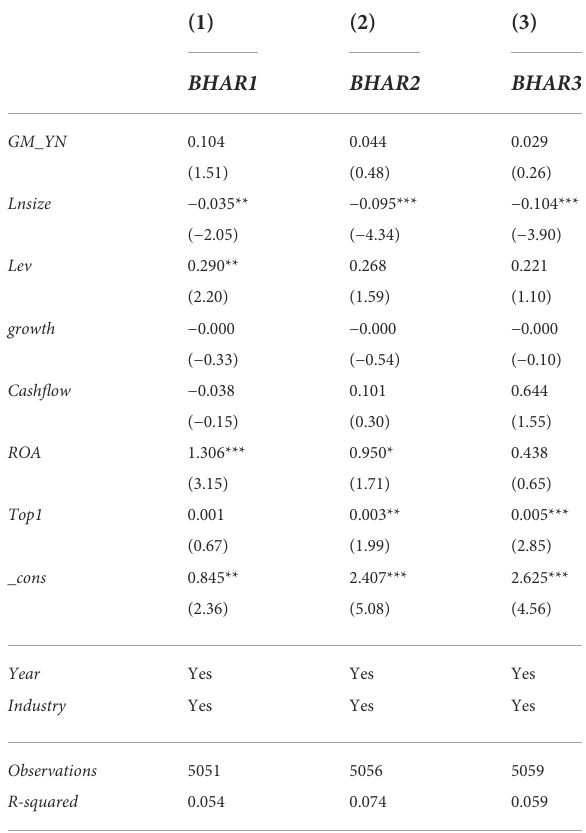
TABLE 11 Long-term M&A